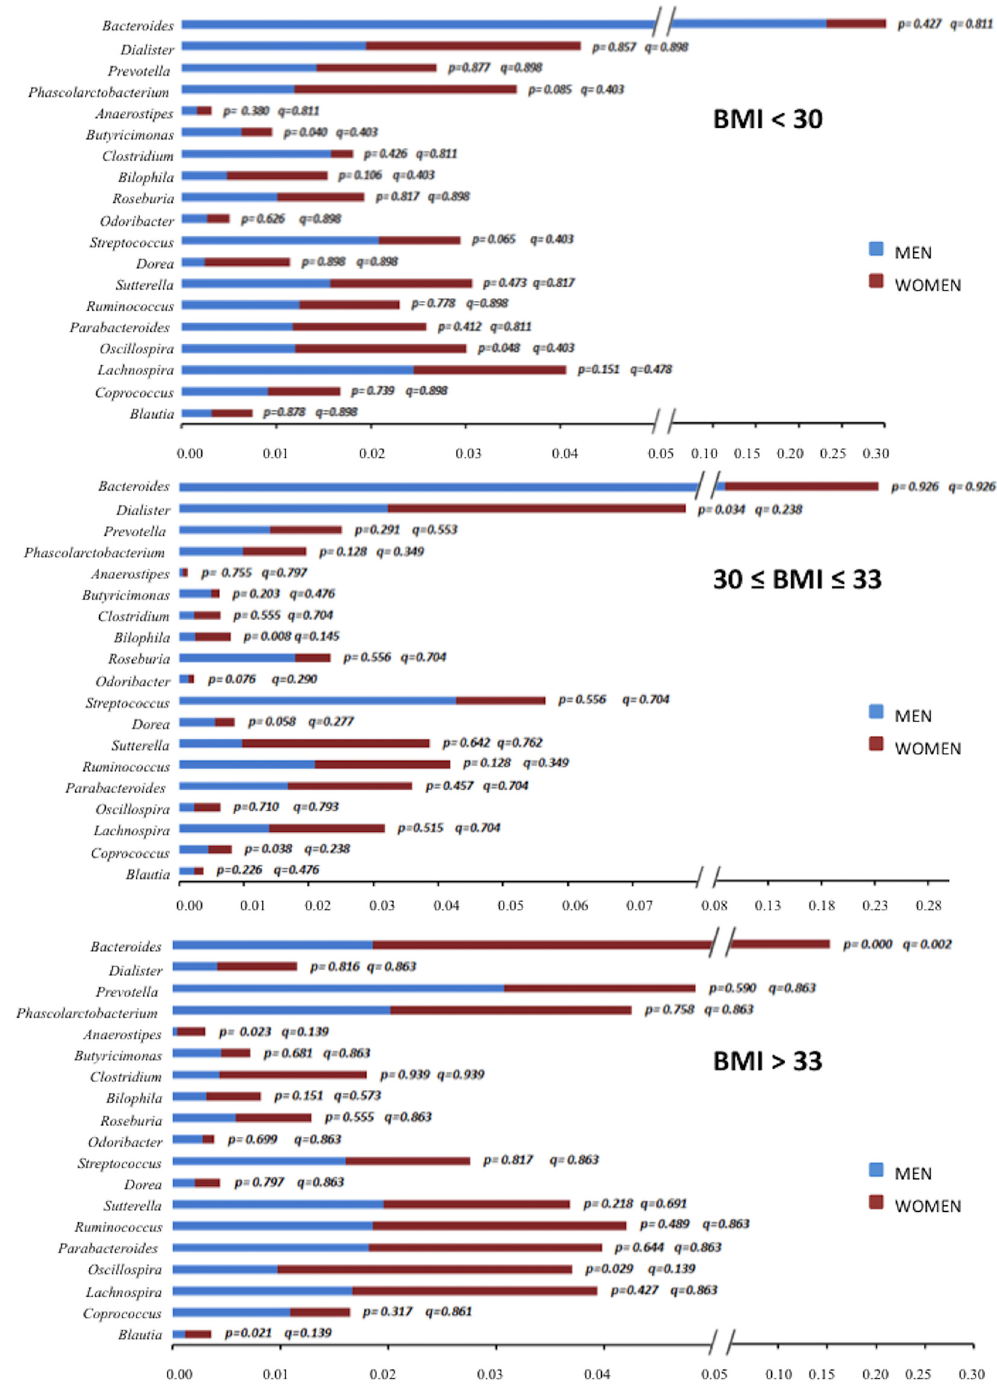
Fig 2. Gender differences in the gut microbiota at different BMI ranges at the genus level. The abundance of the bacterial phyla was obtained by analyzing the 16S rRNA sequences using QIIME. Bars show the comparison of the abundance of the different bacterial species between men and women at different BMI ranges by the Mann- Whitney U test ( P-value ). Q-value : False Discovery Rate (FDR) using Benjamini and Hochberg method. BMI: body mass